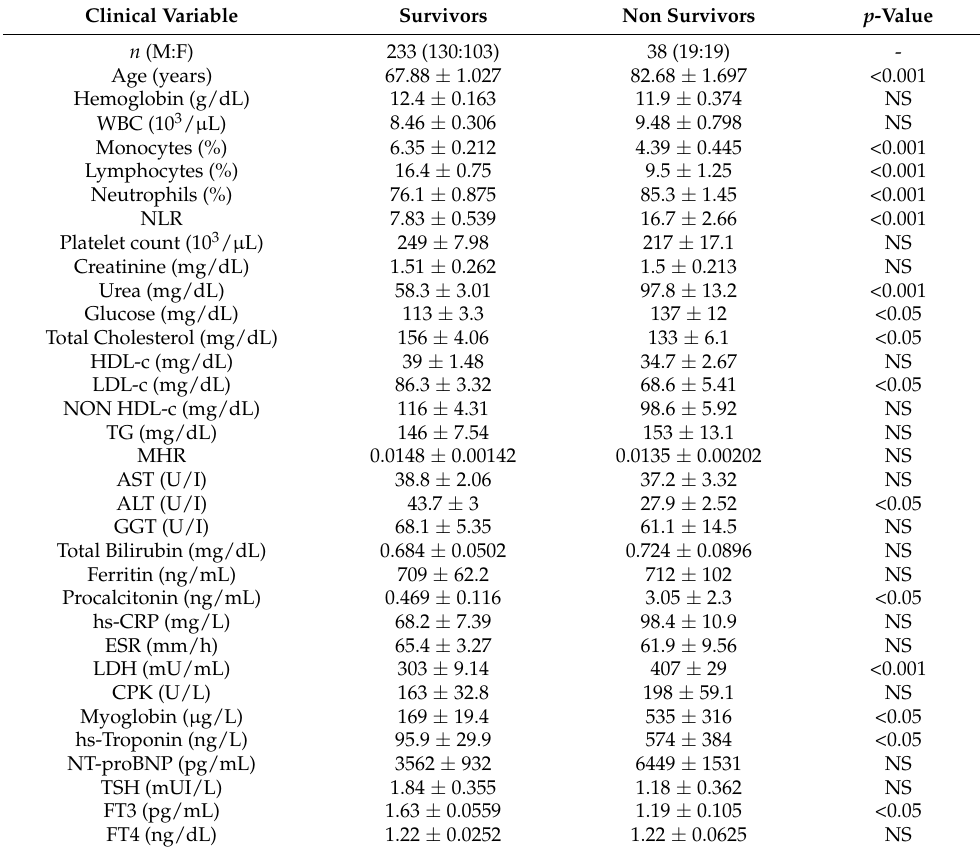
Table 2. Baseline characterization of the study population. Clinical Variable